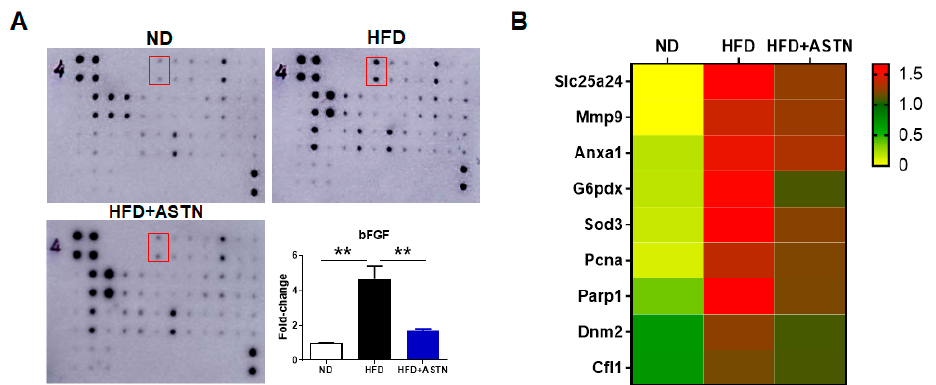
Figure 7. Astaxanthin treatment inhibits FGF2 in the NASH liver. ( A ) Representative images of cytokine assay. Mouse cytokine antibody array was applied to detect 34 mouse cytokines in liver tissues collected from ND-, HFD-, or HFD-ASTN-treated mice. The expression of basic fibroblast growth factor (bFGF) circled in the red box was dramatically increased in the NASH liver, which was significantly inhibited by ASTN treatment. The experiment was repeated. Error bars represent the mean ± SD. Statistical analysis of data was performed by one-way ANOVA using GraphPad Prism 8 software. ** p < 0.01. ( B ) Heatmap showed the expression of proteins in oxidative stress response in Biological Processes of GO: 0034599 and GO: 0006979 (online STRING software) at three indicated treatment groups.